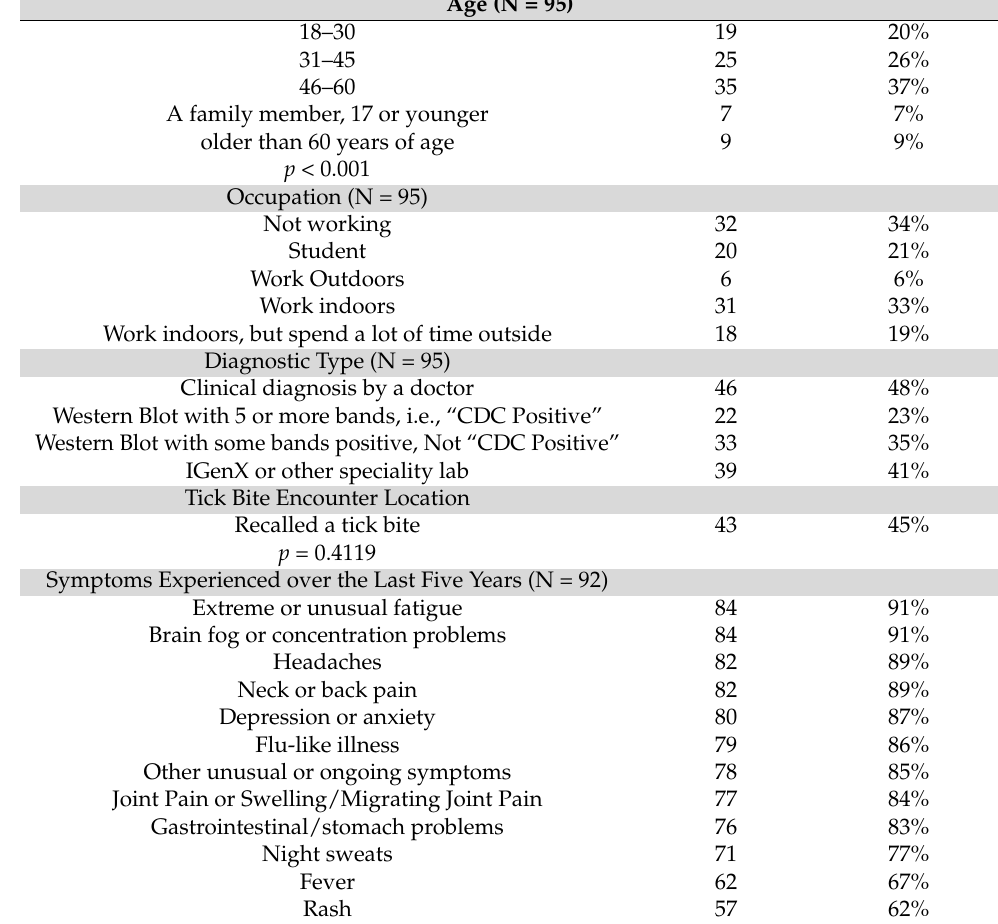
Table 2. TTS respondent